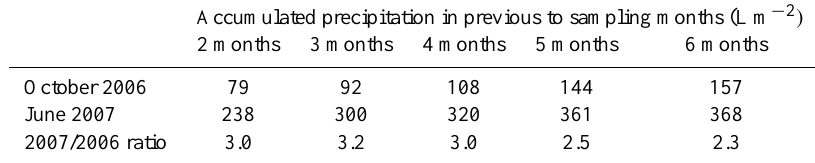
Table 4. Accumulated precipitation during the previous months before sampling in October 2006 and June 2007 and ratios between sam- plings.